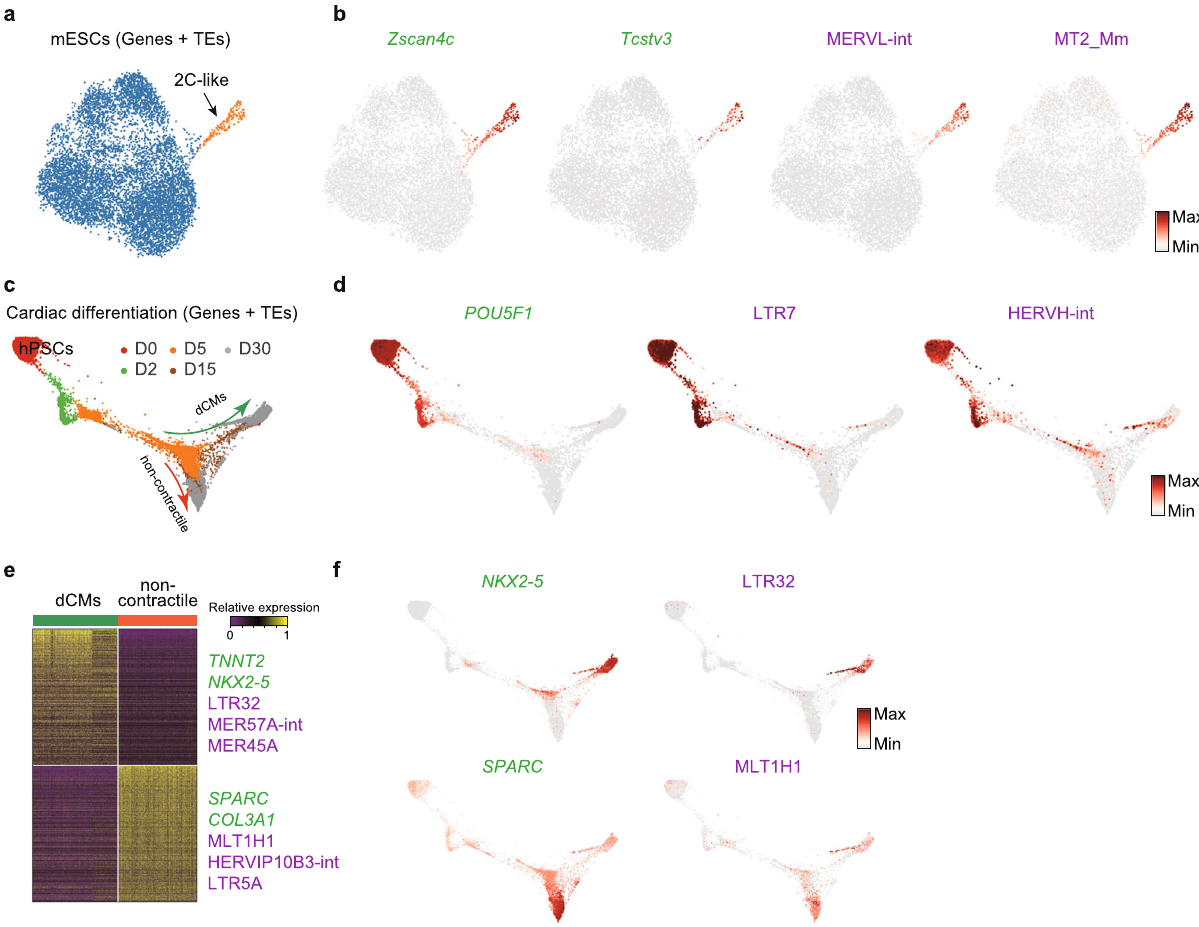
Fig. 2 Dynamic transcription of TEs in ESCs and during cardiac differentiation. a UMAP plot of mouse ESCs. Cells are colored by cell type cluster. b Same as ( a ), but cells are colored based on the expression of the indicated genes and TEs. Zscan4c and Tcstv3 are marker genes for the 2C-like cells. c Trajectory reconstruction of single cells through a cardiac differentiation timecourse showing the de fi nitive cardiomyocytes (dCMs) branch and noncontractile branch. Days of differentiation (D) are labeled. d As in ( c ), but cells are colored by the expression of the indicated genes and TEs. e Heatmap of expression differences between dCM (contractile) branch and noncontractile branch cells, selected differentially expressed genes and TEs are labeled. f As in ( d ), but cells are colored by the expression level of the indicated genes and